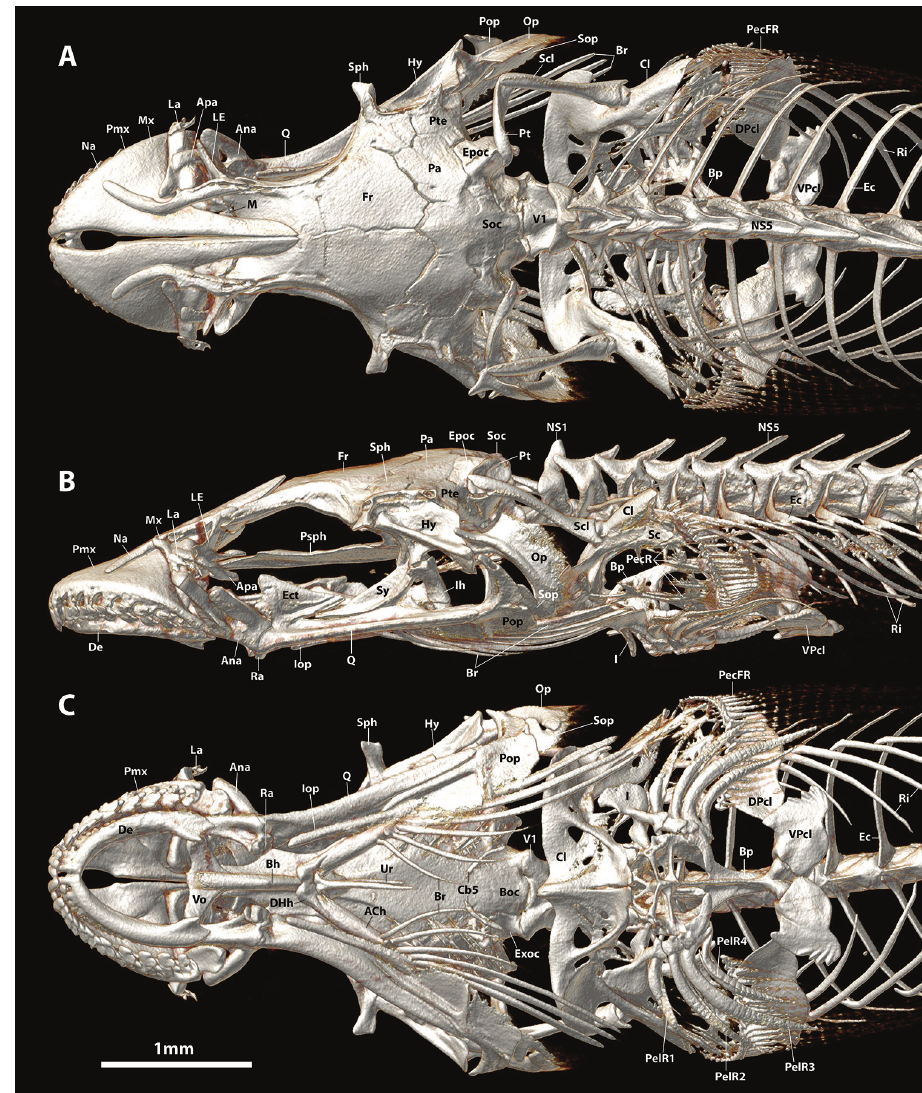
Figure 5. CT scanned anterior skeleton of Flexor incus , AIM MA655316, paratype, 23.0 mm SL. A Dorsal view B Lateral view (left side) C Ventral view. Abbreviations: ACh, anterior ceratohyal; Ana, anguloarticular; Apa, autopalatine; Boc, basioccipital; Bp, basipterygium; Br, branchiostegal rays; Cb5, ceratobranchial 5; Cl, cleithrum; DHh, dorsal hypohyal; DPcl, dorsal postcleithrum; Ec, epicentral; Ect, ectopterygoid; Epoc, epiotic; Exoc, exoccipital; Fr, frontal; Hy, hyomandibular; I, pelvic-fin spine; Iop, interopercle; La, lachrymal; LE, lateral ethmoid; M, mesethmoid; Na, nasal; NS1, 5, neural spine of vertebral centrum 1, 5; Op, opercle; Pa, parietal; PecR, pectoral radial; PecFR, pectoral-fin ray; PelFR1-4, pelvic-fin ray 1–4; Pop, preopercle; Pro, prootic; Psph, parasphenoid; Pt, posttemporal; Pte, pterotic; Q, quadrate; Ra, retroarticular; Ri, rib; Sc, scapula; Scl, supracleithrum; Soc, supraoccipital; Sop, subopercle; Sph, sphenotic; Ur, urohyal; V1, vertebral centrum 1; Vo, vomer; VPcl, ventral